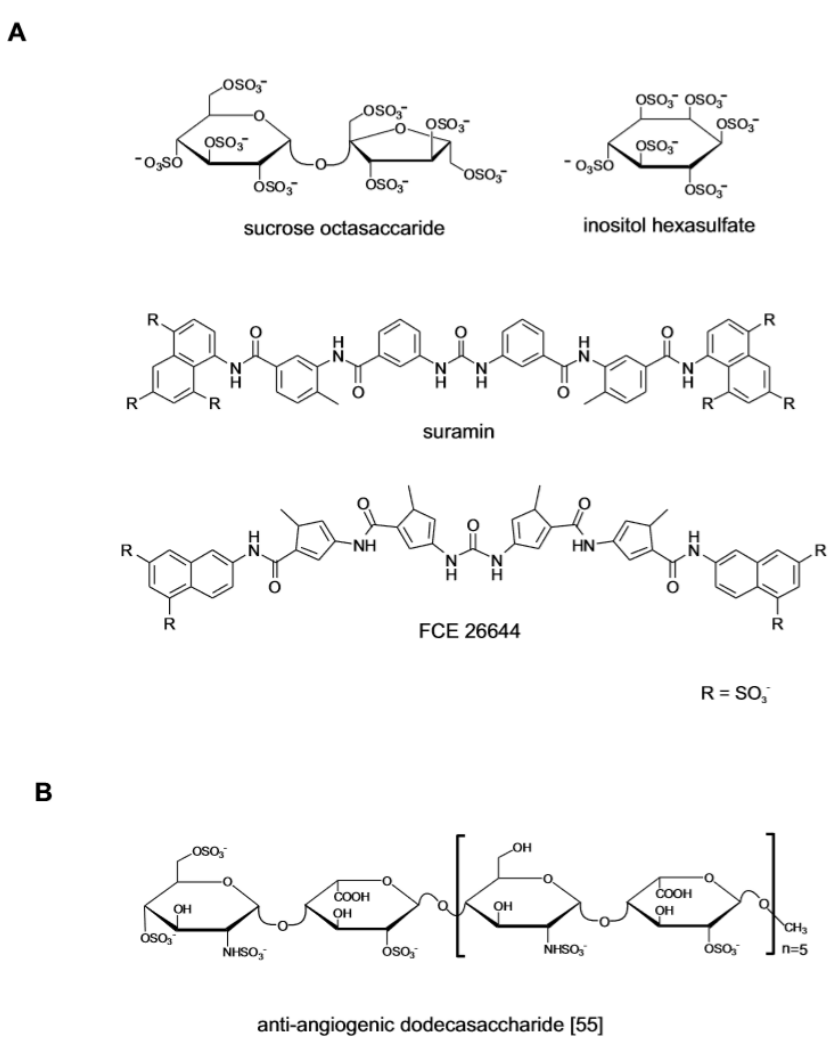
Figure 2. Small molecule FGF ligands and rationally designed oligosaccharides. ( A ) Early investigated polysulfated small molecule drugs with anti-angiogenic activity. ( B ) Structurally defined heparin-like dodecasaccharide generated through a completely synthetic process. Structure redrawn from ref. [55].